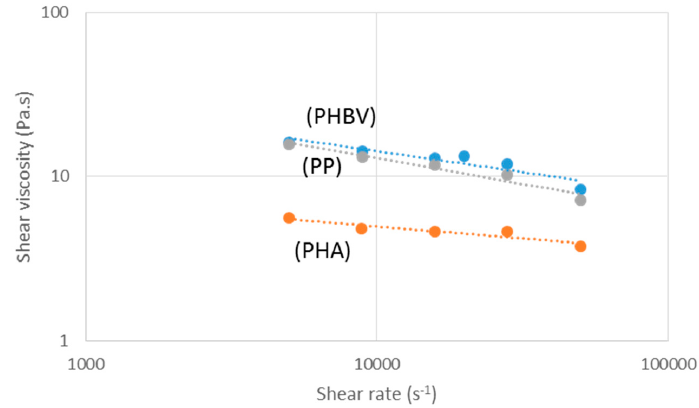
Figure 3. Shear viscosity versus shear rate of the feedstock with PP, PHBV and PHA and 60% of volume fraction of powder.